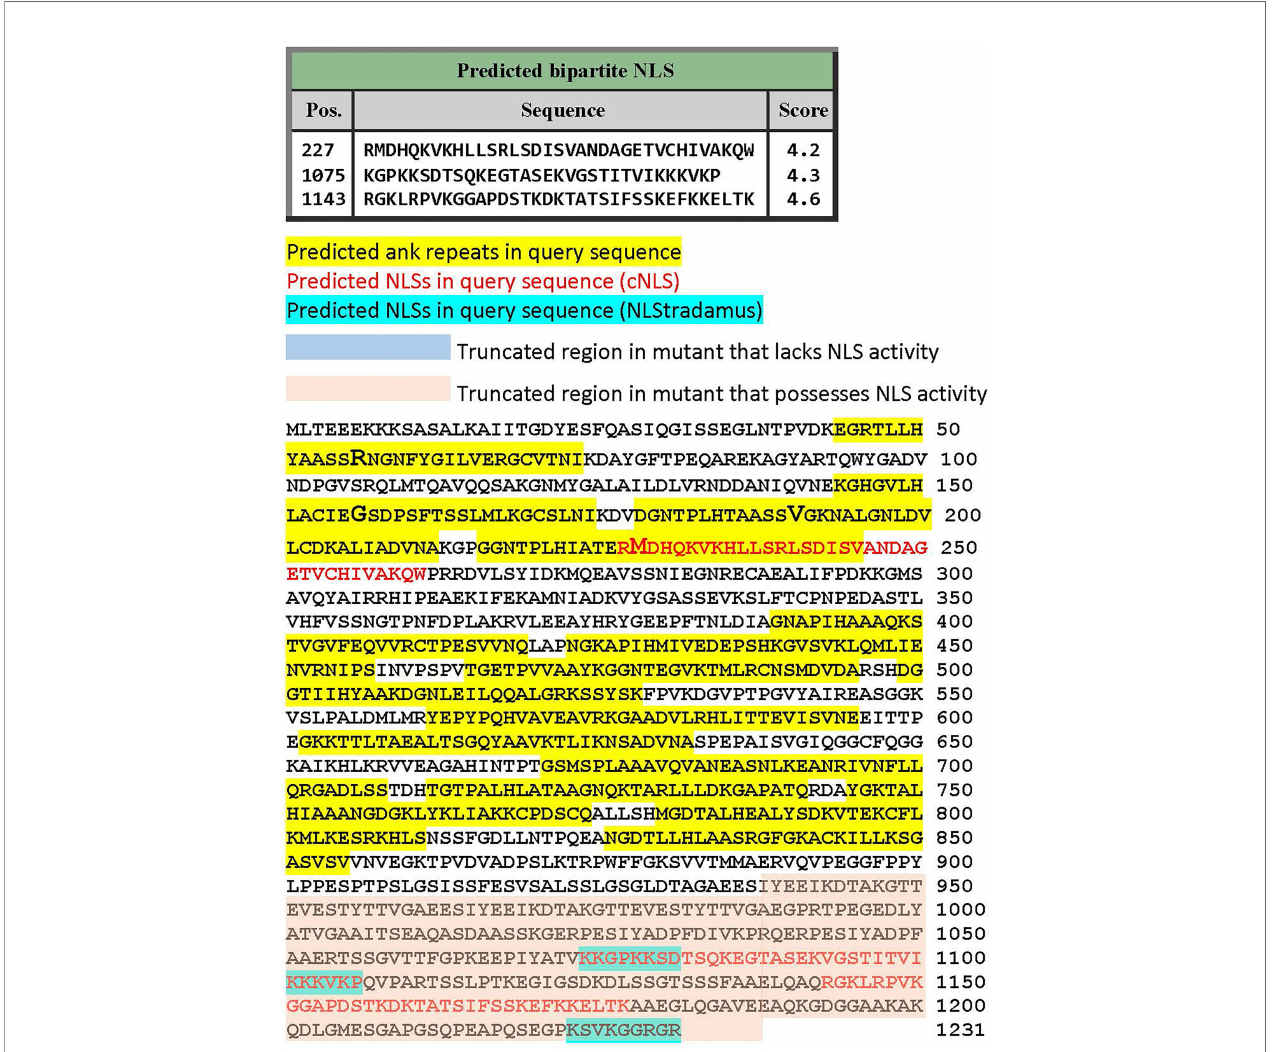
FIGURE 7 | Prediction of importin- a / b pathway NLSs in full length A. phagocytophilum Webster T strain AnkA. Three predictive algorithms were applied to identify putative NLSs. Shown is the full-length AnkA protein sequence with yellow highlights for the ankyrin repeats, ankyrin repeat mutations in enlarged font, NLS predicted by the cNLS Mapper algorithm (see text) in red text, and NLS predicted by NLStradamus (see text) in blue highlights. Note the predicted NLS overlapping the 4 th ankyrin repeat including the site of mutation that led to diminished nuclear